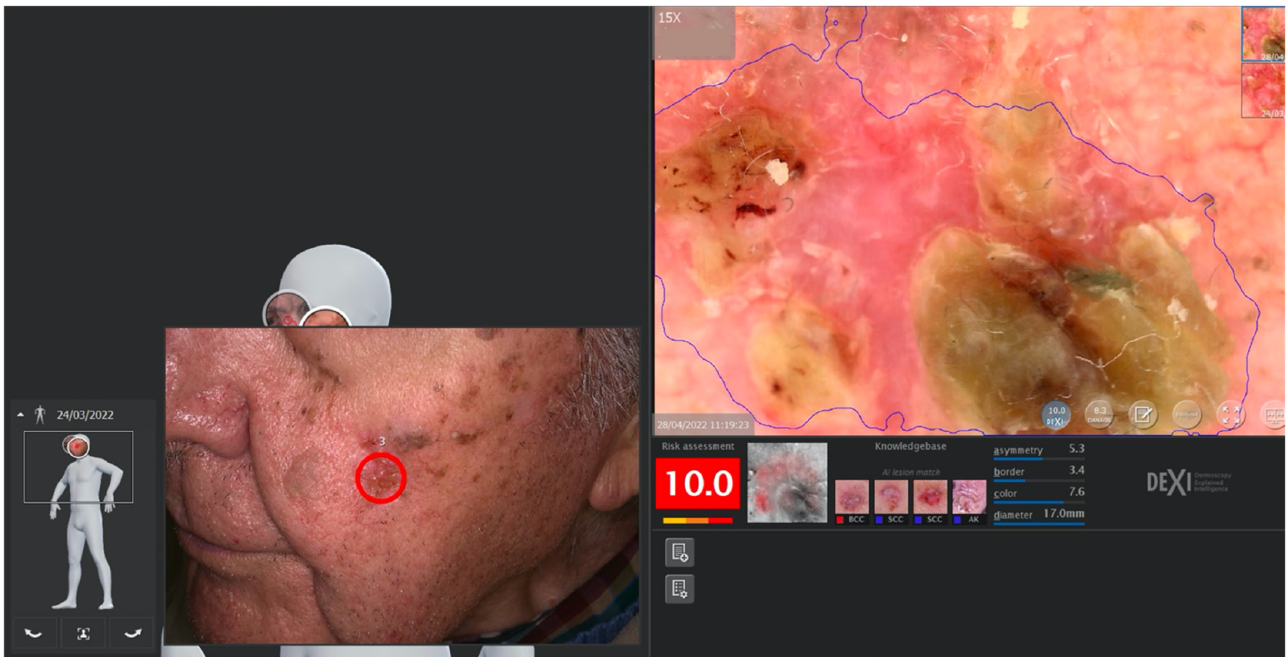
Figure 4. 2-Dimensional photography. DermagraPhix ® . The selected area also includes a dermato- scopic view, with an artificial intelligence score. scopic view, with an artificial intelligence